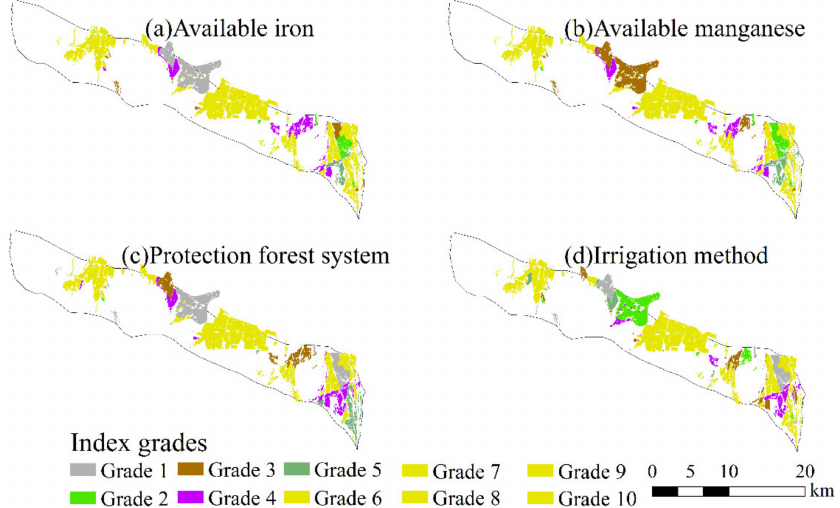
Figure 7. Spatial distribution of the influential factors at the upper part of the diluvial fan. ( a ) Available iron, ( b ) Available manganese, ( c ) Protection forest system, and ( d ) Irrigation